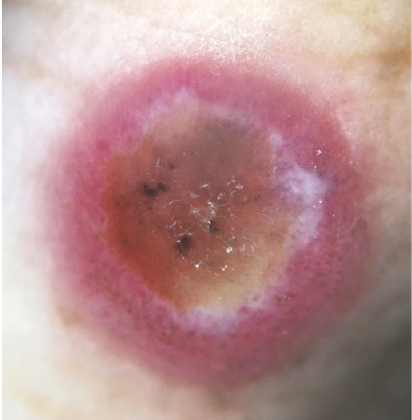
Figure 4: Electron microscopy showing numerous viral particles (DNA core surrounded by double layered capsid) (red arrow). Insert: polymerase chain reaction (PCR) orf virus result. 2% agarose gel, with PCR product with ORF1/ORF2 primers, specific for orf virus; 140pb positive fragment (white circle); DNA ladder (100pb).